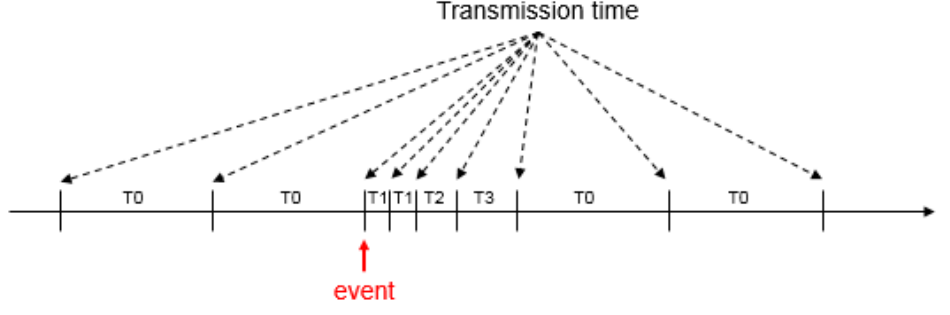
Figure 9. Example of changing time between message publications.